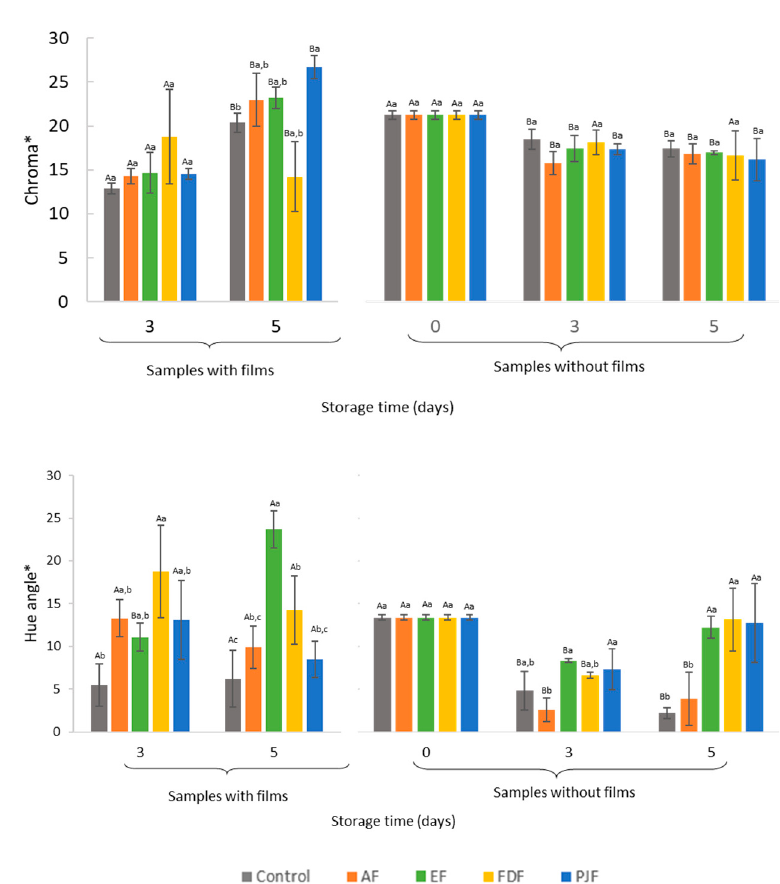
Figure 3. Color parameters of the samples with or without films after five days of storage at the refrigerated conditions. Different lowercase letters represent a statistically significant difference among results for the same storage time ( p < 0.05). Different capital letters represent statistically significant parameter values of the same sample over the storage period ( p < 0.05). Alginate film with microparticles with encapsulated hydroalcoholic extract (EF), alginate film with pineapple-peel-juice microparticles (PJF), alginate film with freeze-dried peel powder (FDF), and control films only with alginate (AF).